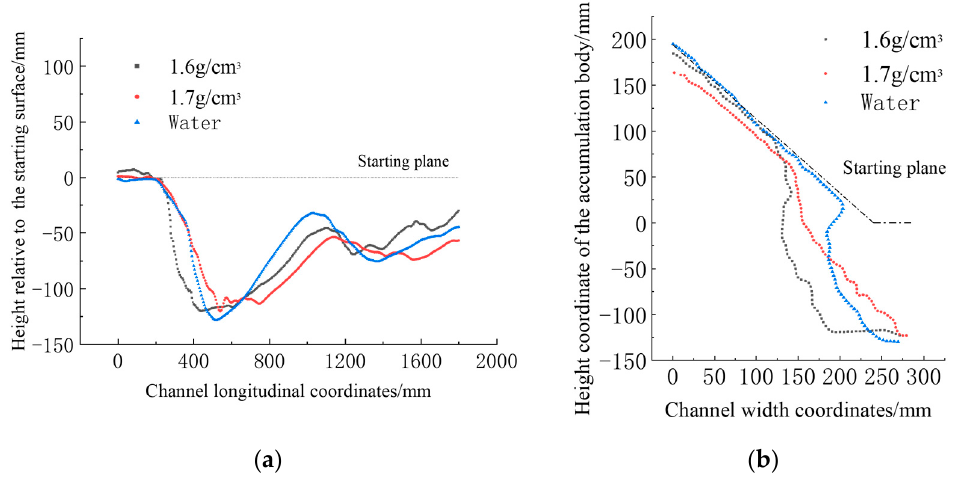
Figure 7. Characteristic cross-sections of different graded mounds after erosion by debris flow ( a ) Cross-section at maximum erosion depth.( b ) Cross-section at maximum erosion width.